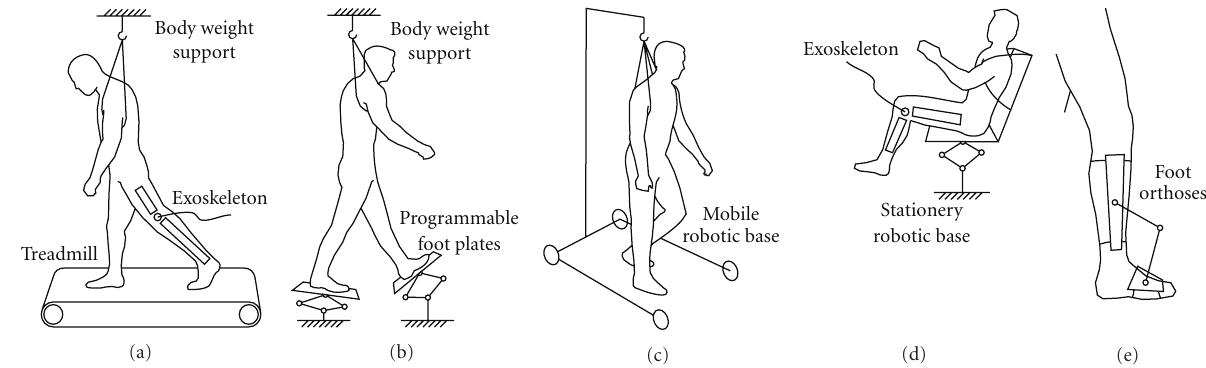
Figure 1: Robotic system types for lower-limb rehabilitation: (a) treadmill gait trainers, (b) foot-plate-based gait trainers, (c) overground gait trainers, (d) stationary gait and ankle trainers, and (e) active foot orthoses.